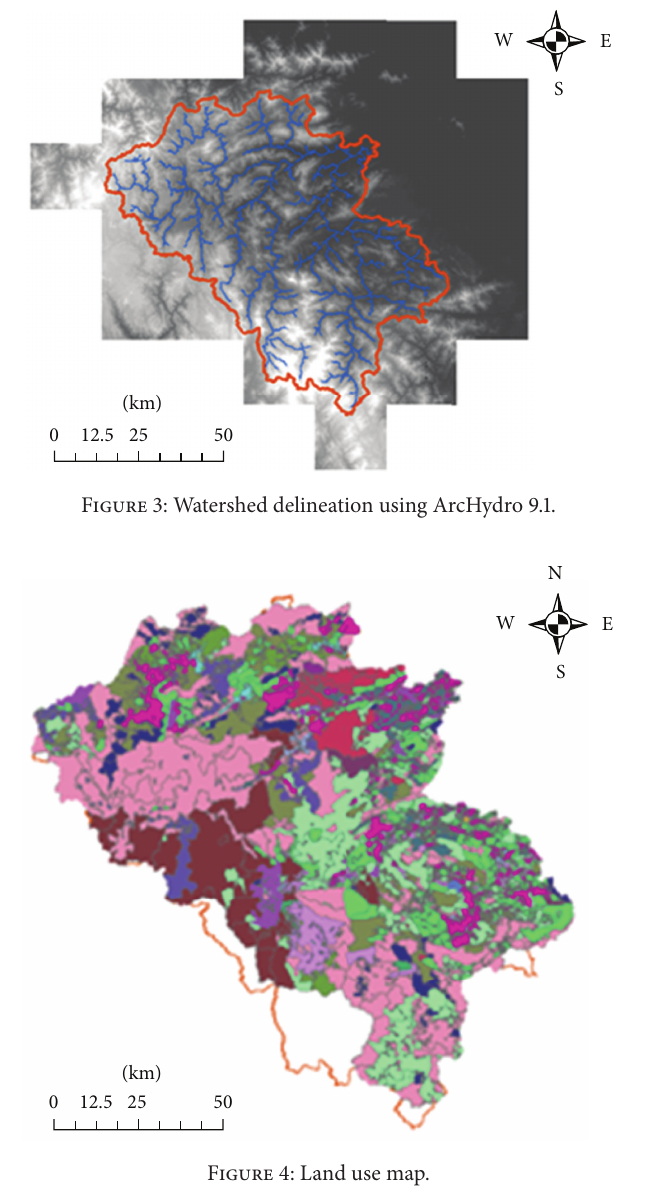
Figure 4: Land use map.